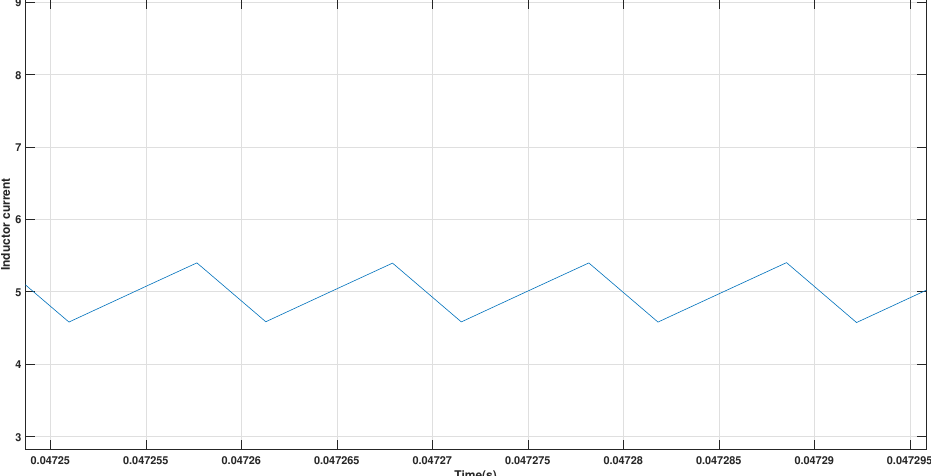
Figure 6. Inductor current ripple of system with CI-ISE and r i =